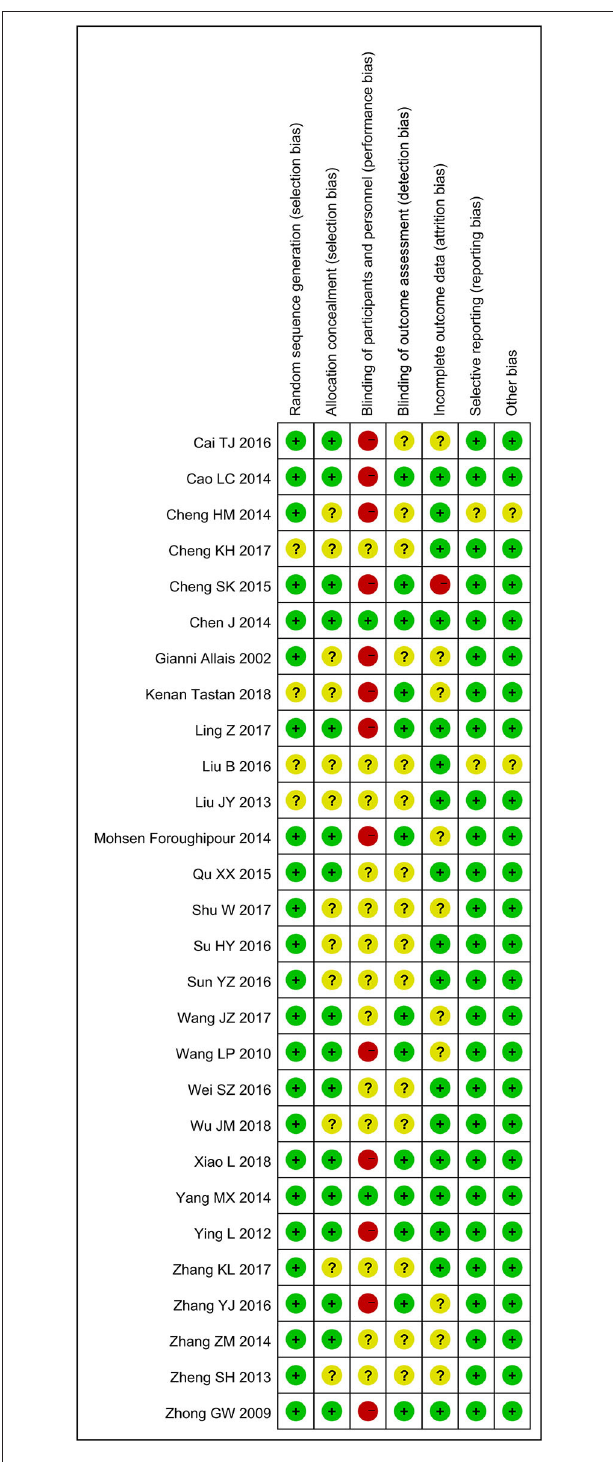
FIGURE 2 | Bias risk summary